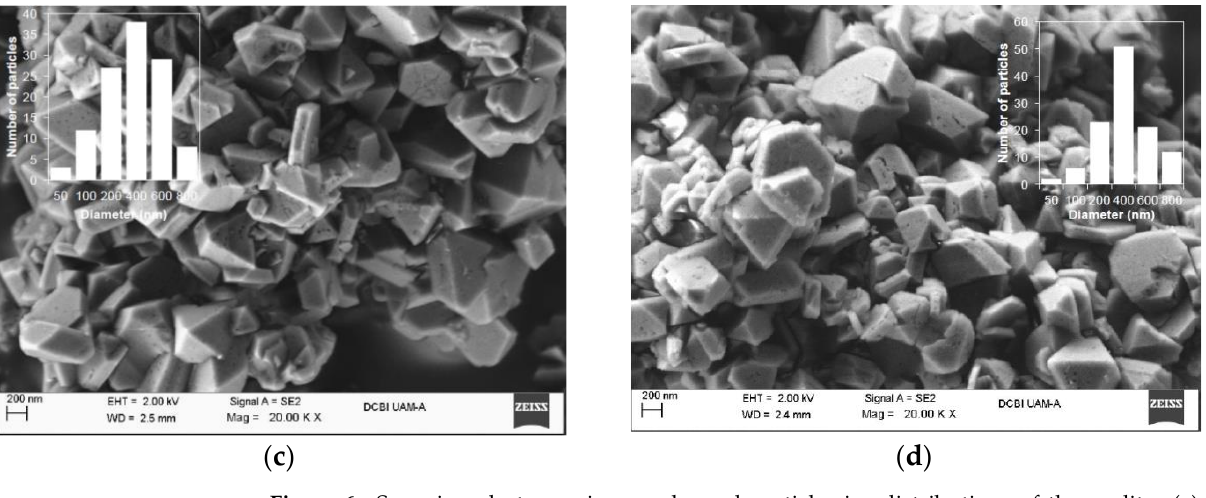
Figure 6. Scanning electron micrographs and particle size distributions of the zeolites ( a ) ZY7, ( b ) ZY17, ( c ) ZY34, and ( d ) ZY45.